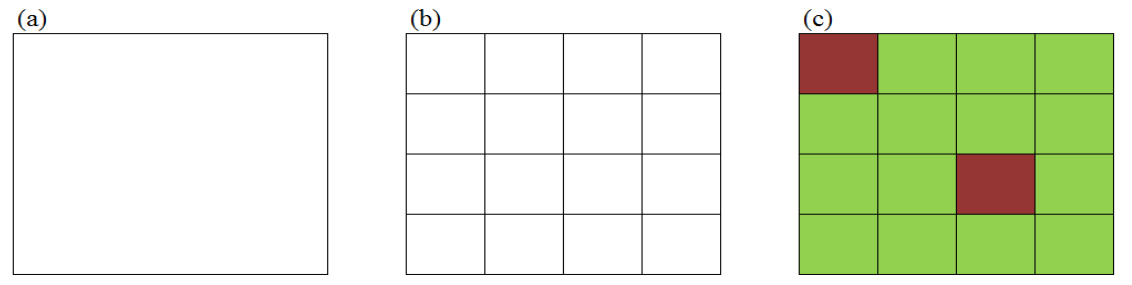
Figure 1. ( a ) One pixel from an original spatial resolution Landsat 4/5 thermal infrared (TIR) band; ( b ) original TIR pixel resampled to 4 × 4 pixels to match the pixels of the higher spatial resolution visible-to-near infrared (VNIR) bands; ( c ) resampled TIR training pixels (green cells) and validation pixels (red cells) in one fold of a cross-validation, assuming approximately 10% of pixels are held out for